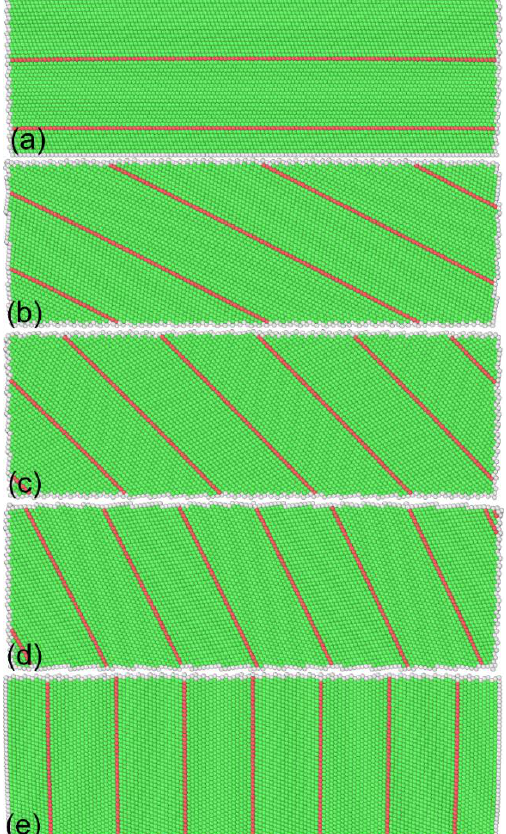
Figure 1. Atomic structures of nanotwinned Al containing differently inclined twin boundaries (TBs). Inclined angle of TBs: ( a ) 0 ◦ ; ( b ) 26 ◦ ; ( c ) 45 ◦ ; ( d ) 64 ◦ ; and ( e ) 90 ◦ . Atoms are colored according to their common neighbor analysis (CNA)